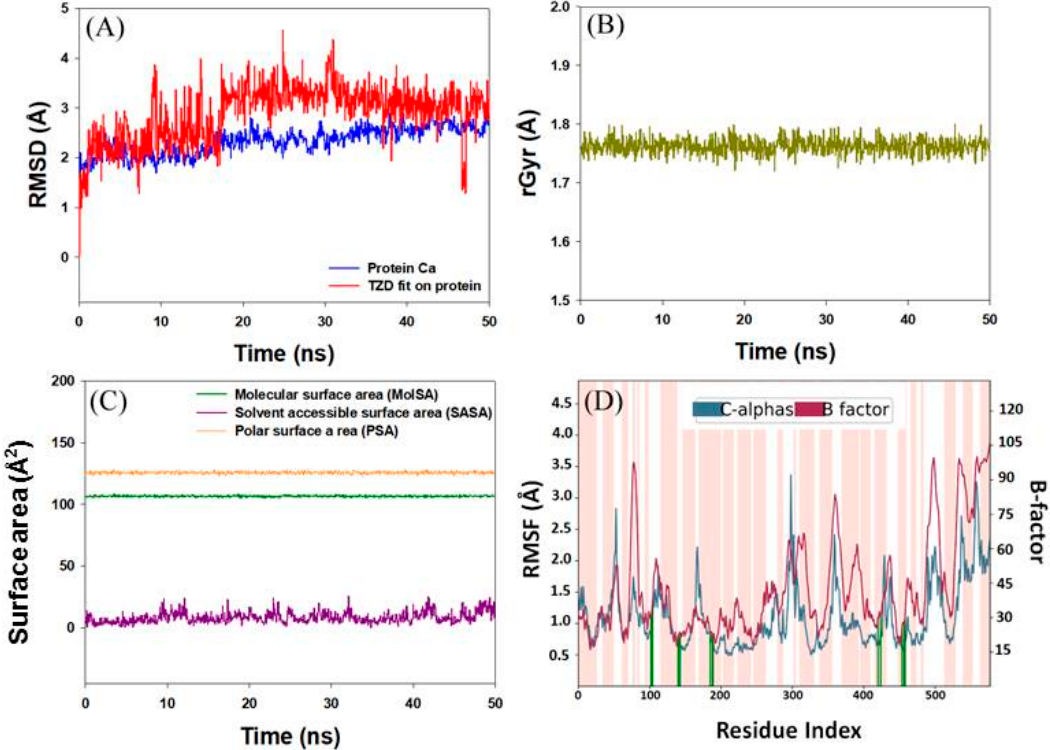
Figure 8. Molecular dynamics simulation of HSA-2,4-TZD complex. ( A ) Dependence of RMSDs of HSA in the absence and presence of 2,4-TZD on simulation time. ( B) Fluctuation in radius of gyration (rGyr). ( C ) Variations in surface areas with respect to simulation time. ( D ) Dependence of RMSF, B-factor, and point of contact between HSA and 2,4-TZD as a function of simulation time.